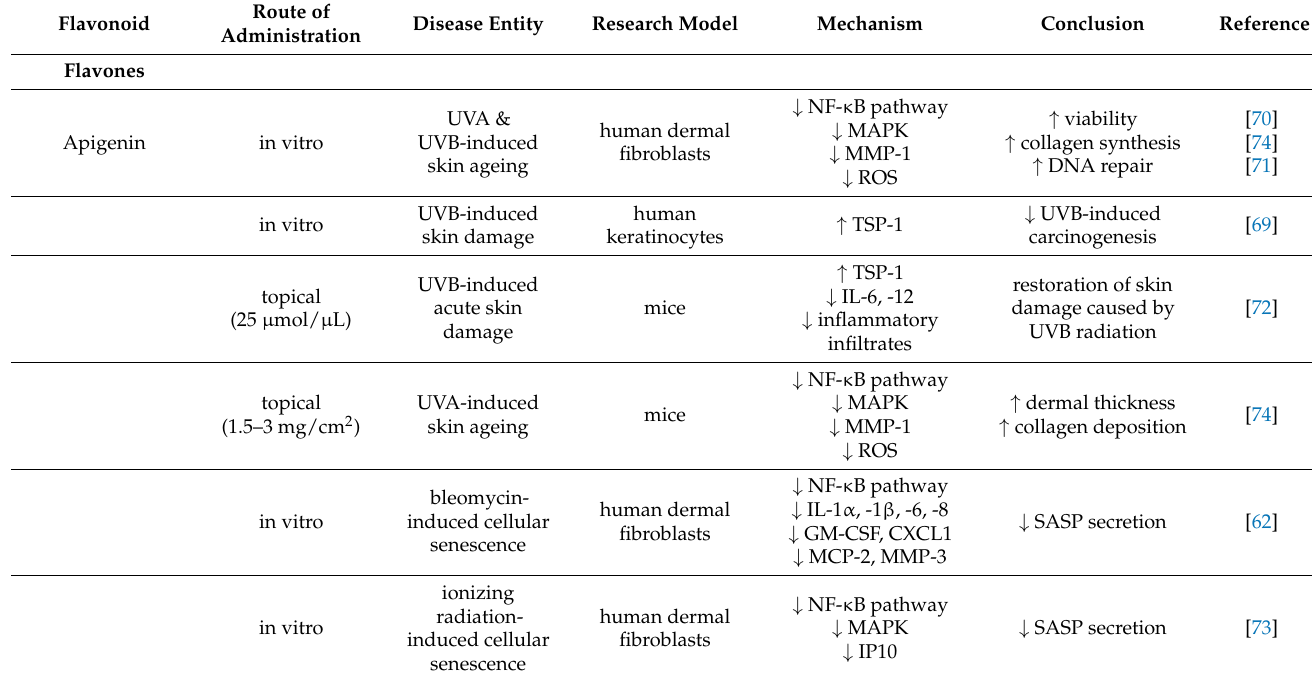
Table 1. Mechanisms of senolytic and senostatic actions of flavonoids in the context of skin aging. Route of Flavonoid Administration